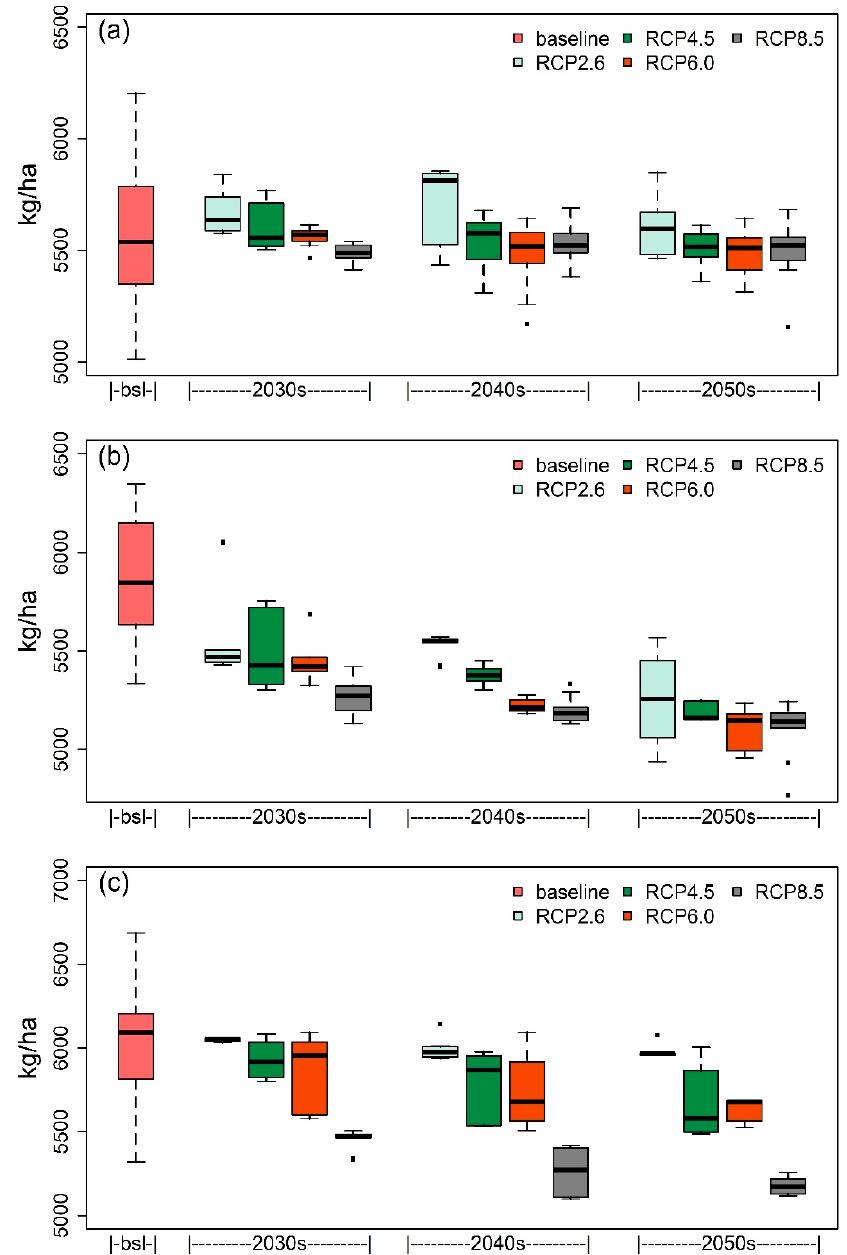
Figure 6. Future rice production under climate change scenarios in three different growing seasons: ( a ) wet season, ( b ) first dry season, and ( c ) second dry season.